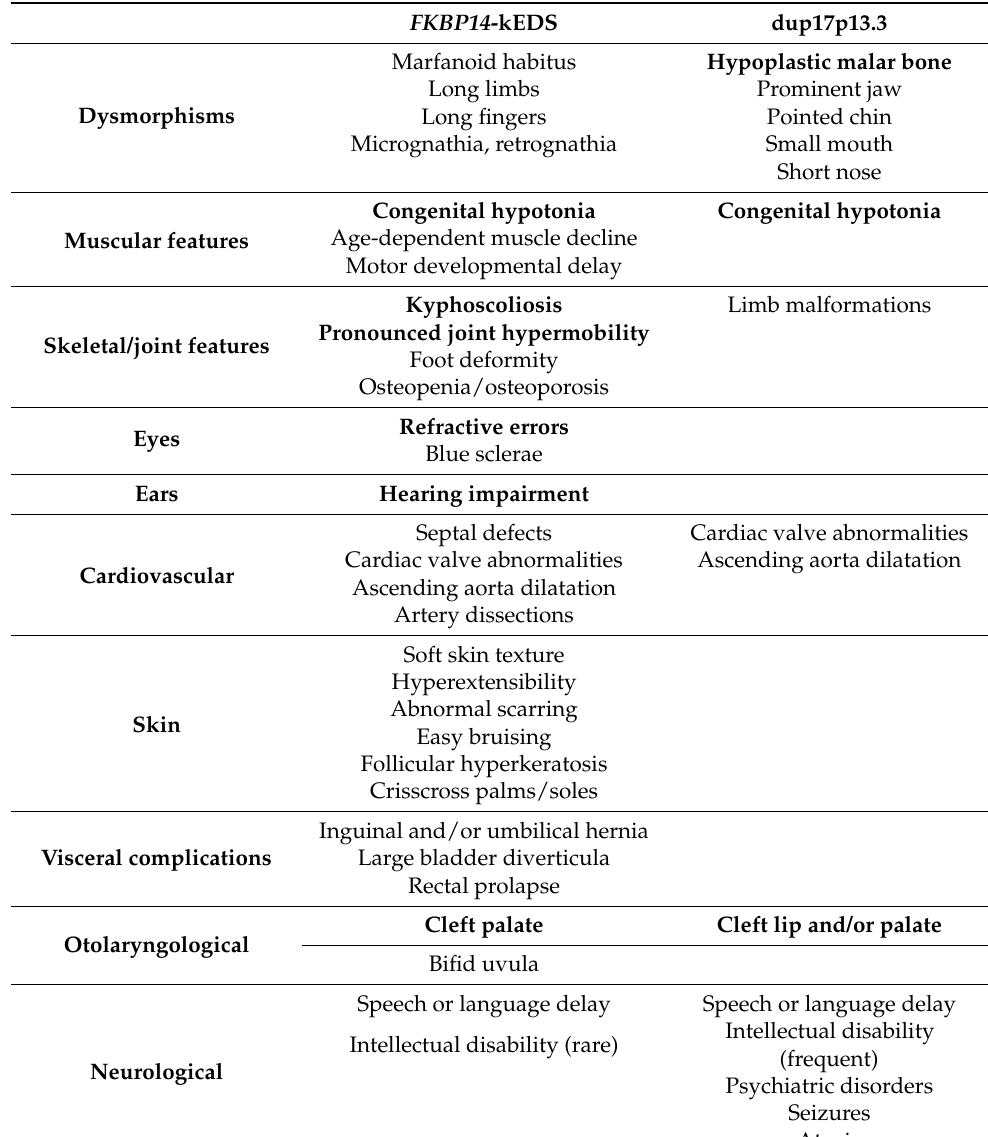
Table 1. Clinical aspects of FKBP14 -kEDS and